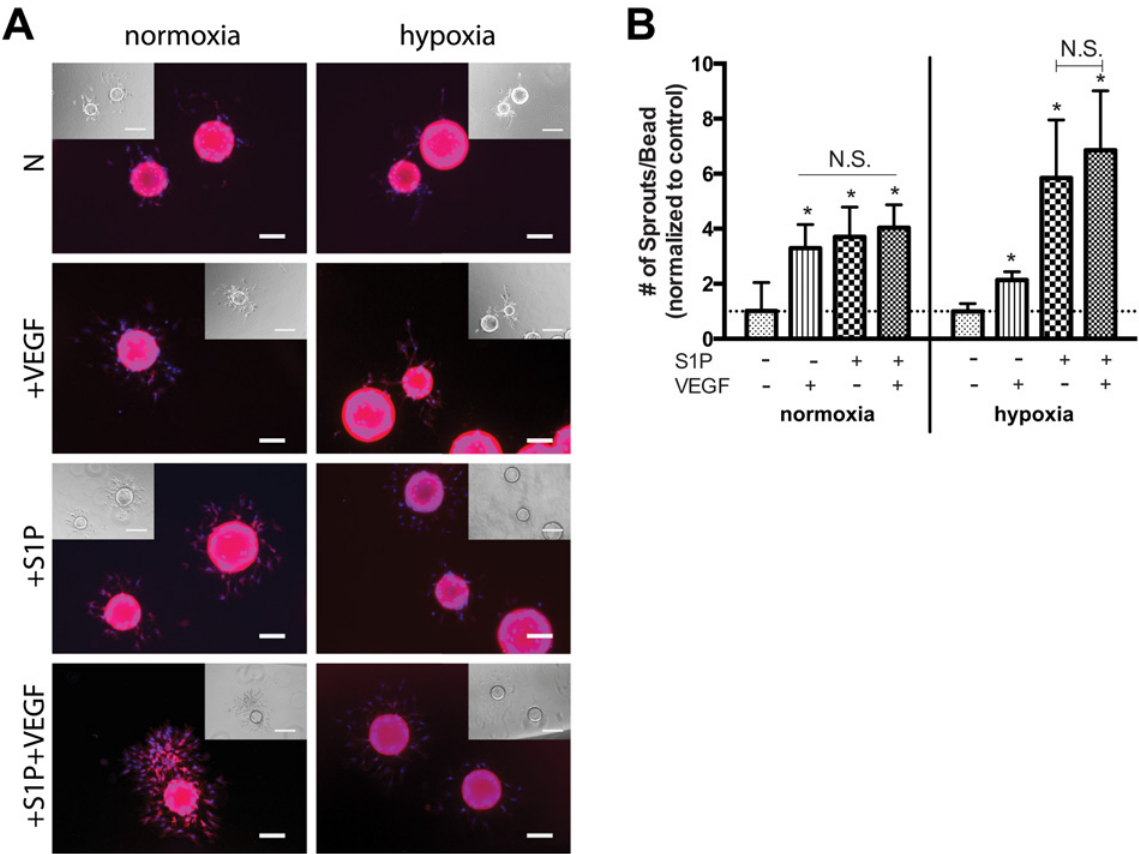
Fig 4. Hypoxia augmented the angiogenic response of OECs to S1P stimulation in terms of 3D sprouting formation. S1P and/or VEGF induced OEC sprouting in a fibrin gel after 1 day of culture in normoxia and hypoxia (A). S1P alone or in combination with VEGF led to significantly more sprouts per bead than VEGF alone under hypoxia (B). Scale bars represent 100 μ m and 200 μ m (DIC inlay). Data are mean ± SD (n = 4) and normalized to the average untreated control values for either normoxia or hypoxia (indicated by the dashed line) accordingly. An asterisk indicates statistically significant differences (P < 0.05) between conditions in normoxia or hypoxia respectively and N.S. displays no statistically significant difference between